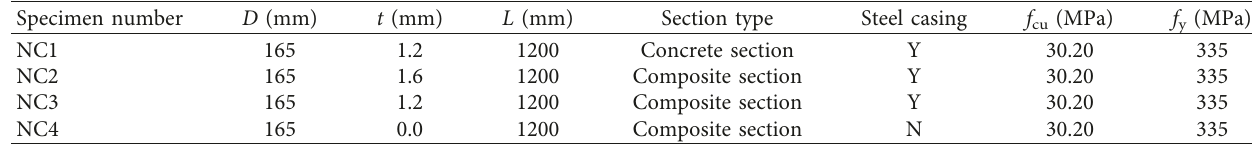
Table 2: Details of the specimens.